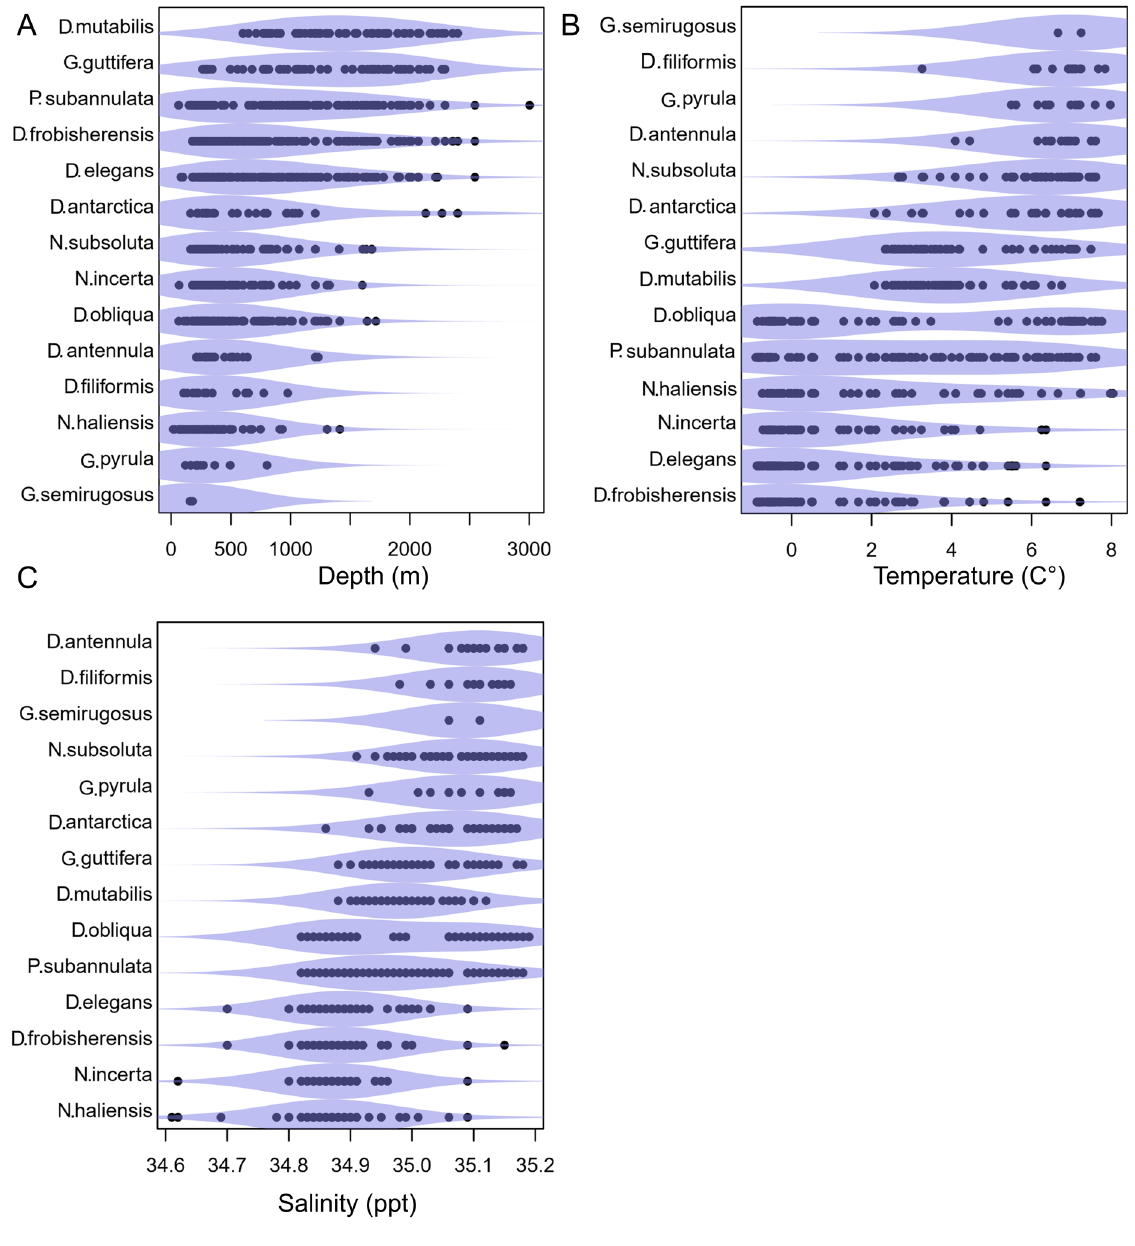
Fig. 18. Kernel density smoothed distribution (violin plots) of species along physical gradients. A . Depth (m). B . Temperature (°C). C . Salinity (ppt); omitted are two outlier salinity records for N. haliensis Eiland & Guðmundsson, 2004 (33.98 and 34.34 ppt) and one for P. subannulata (Cushman, 1923) (34.3 ppt). Based on BIOICE samples of the RP-epibenthic and detritus